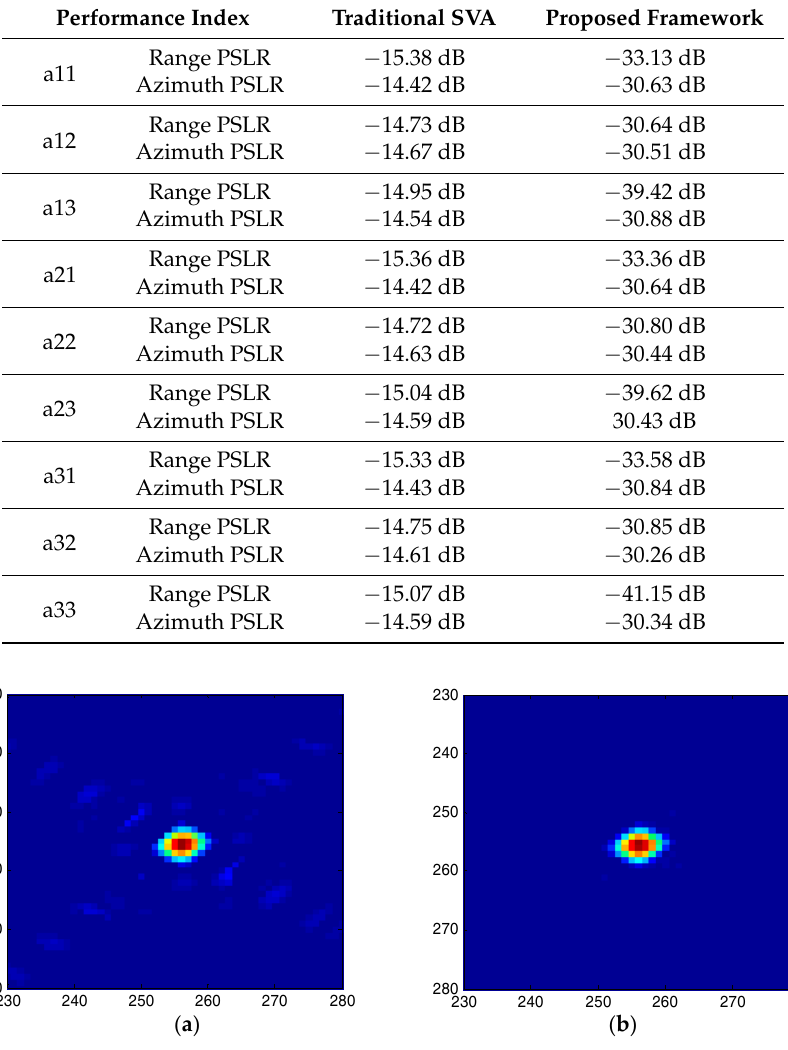
Figure 13. Sidelobe reduction results of squint SAR image ( a ) Processed result by using the method of References [9]; ( b ) Processed result by using the proposed method.